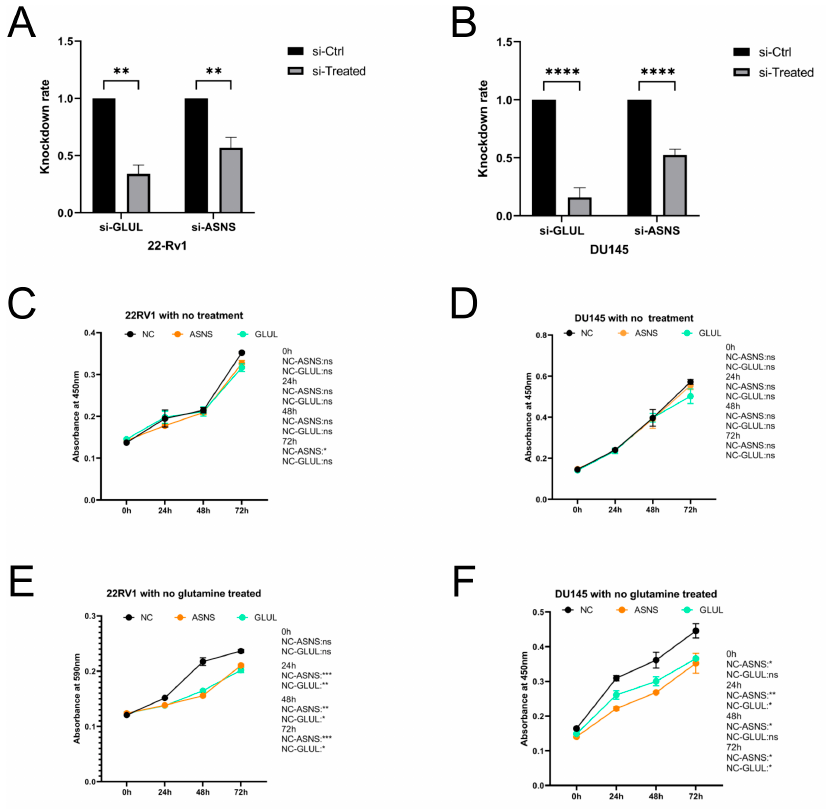
Figure 10. Cell viability of 22Rv1 and DU145 cells after siRNA knockdown of GLUL or ASNS. ( A , B ) Knockdown efficiency of siRNA-GLUL and siRNA-ASNS in DU145 and 22Rv1 cell lines by qPCR. ( C , E ) The CCK8 proliferation assay of the no treatment groups. ( D , F ) The CCK8 proliferation assay of without-glutamine-treated groups. * p < 0.05, ** p < 0.01, *** p < 0.001, **** p < 0.0001, ns represents no significant difference.